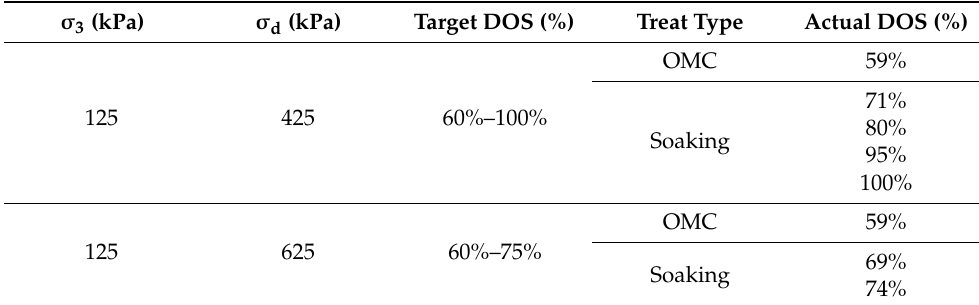
Table 1. Repeated loading triaxial testing program of unbound